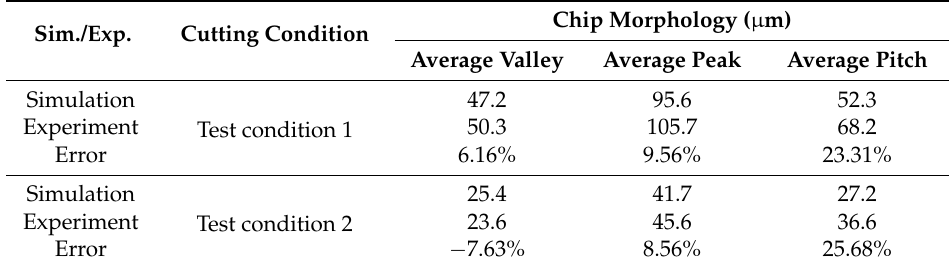
Figure 4. Comparison of the simulated (Sim.) and experimental (Exp.) chip morphologies in Ti ‐ phase cutting modeling [36]: ( a ) test condition 1 ( v c = 1200 m/min and f = 70 μ m/rev); ( b ) test condition 2 ( v c = 4800 m/min and f = 35 μ m/rev) (Note: the symbol “S” in the figure represents the von Mises stress and the unit is MPa). Table 7. Comparison between simulated (Sim.) and experimental (Exp.) chip geometries in Figure 4. Sim./Exp.